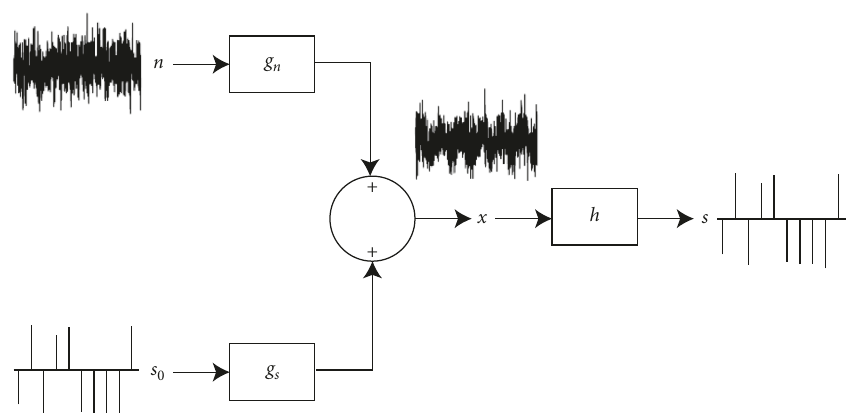
Figure 1: General scheme of blind